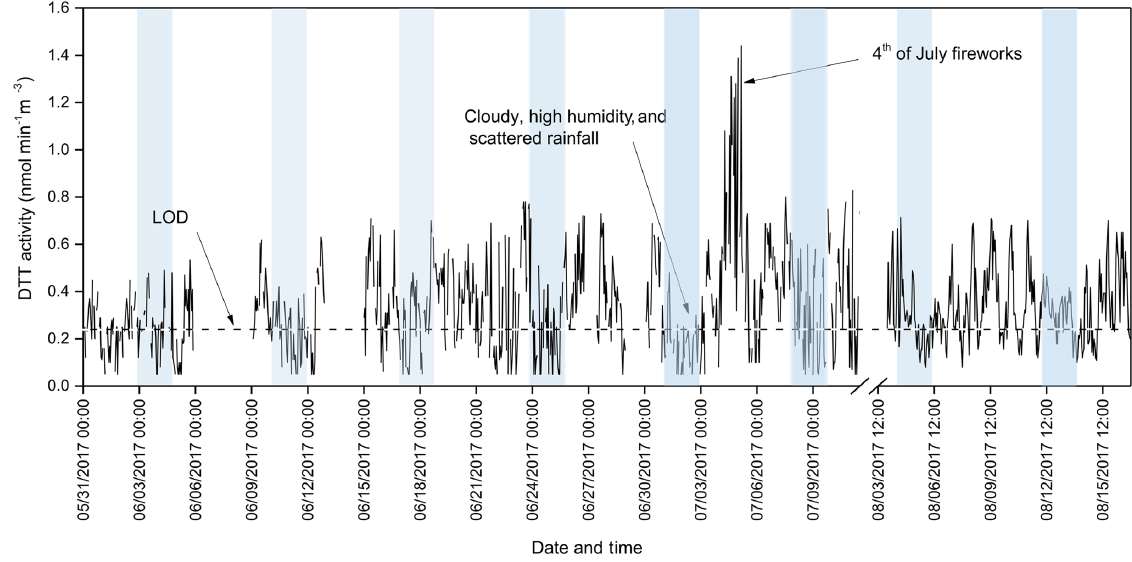
Figure 3. Time-series plot of the DTT activity from 31 May to 16 August 2017. The shaded portions in the graph are weekend DTT activity measurements. The instrument was not operated between 12 July and 3 August 2017 (shown as a break in the x